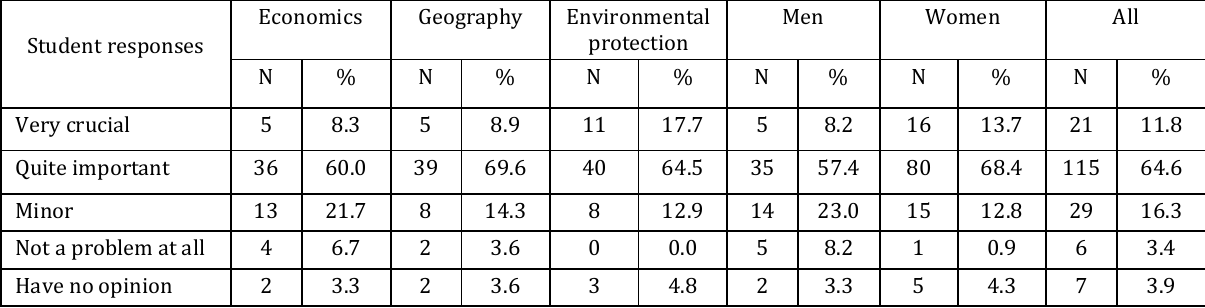
Table 9. The responses of the students to the question 2 - "How serious do you believe the problems are with the Environment?" Economics Geography Student responses